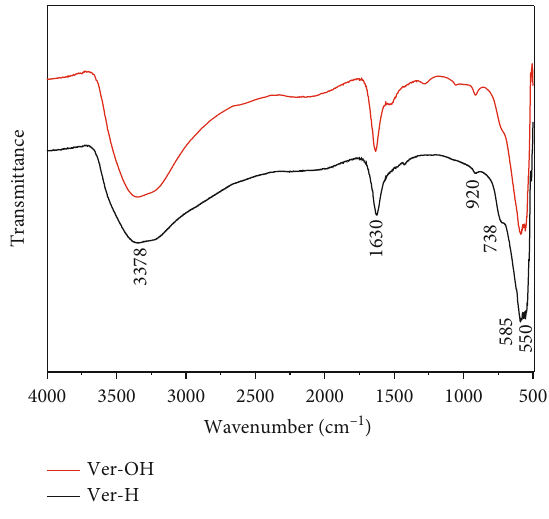
Figure 4: FTIR spectra of synthetic